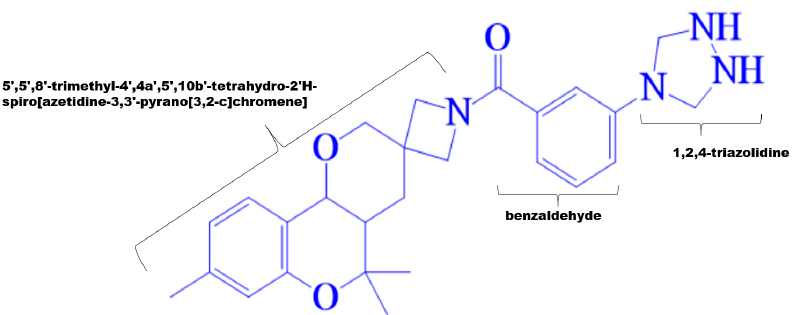
Figure 2. Structural dissection of the hit molecule virtually screened against SARS-CoV-2 helicase enzyme.